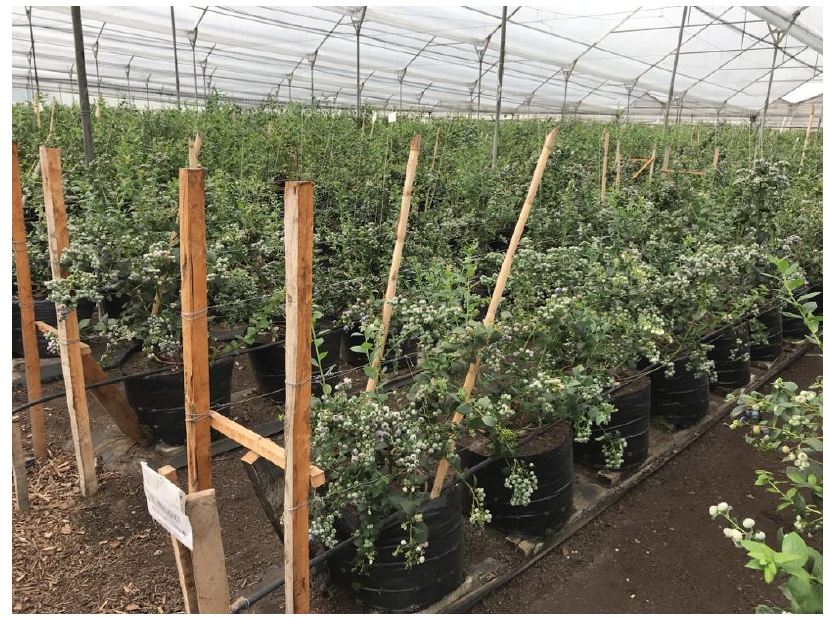
Figure 6. Example of trellis for plant anchorage used in container-based production system for southern highbush blueberry.